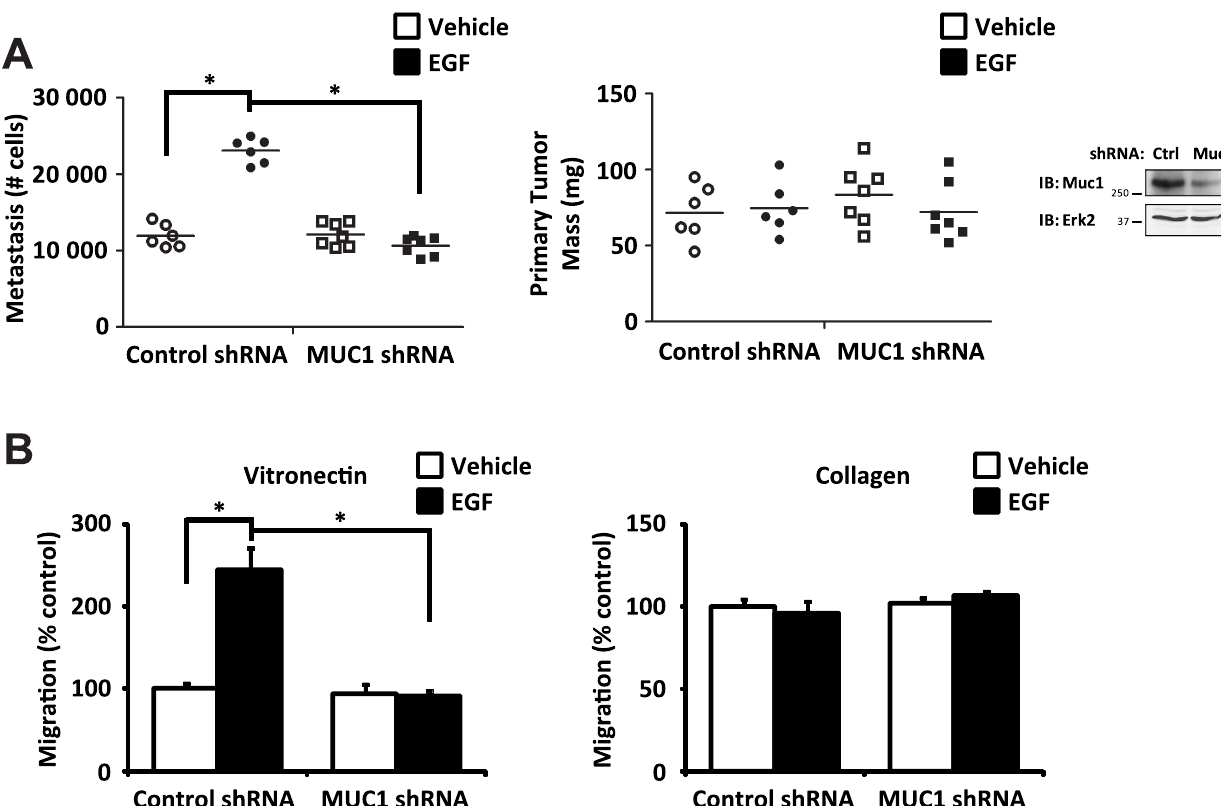
Figure 1. MUC1 is required for EGF-dependent tumor cell metastasis. ( a ) FG human pancreatic carcinoma cells expressing a control shRNA or MUC1 shRNA and stimulated with or without a 15 minute treatment of EGF were inoculated on to the chorioallantoic membrane of 10 day-old embryonated chicken eggs and assessed for spontaneous pulmonary metastasis (left) and primary tumor formation (right) after 10 days. Cells were washed with PBS prior to inoculation to remove EGF. Metastasis quantified by Q-PCR for human Alu sequence and chicken GAPDH was normalized to a standard curve. Each point represents a separate egg, n $ 6 eggs per group. Immunoblot detecting MUC1 expression (far right). P , 0.0001 comparing metastasis for cells expressing control shRNA with or without EGF treatment; P =0.08 comparing metastasis for cells expressing MUC1 shRNA with or without EGF treatment; P , 0.0001 comparing metastasis for cells expressing control shRNA or MUC1 shRNA with EGF treatment; P =0.6 comparing primary tumor mass across groups. ( b ) Migration assays on a vitronectin (left) or a collagen (right) substrate comparing FG cells expressing a control shRNA or MUC1 shRNA with or without a 15 minute pre-treatment of EGF. Cells were washed with PBS prior to inoculation on Boyden chambers to remove EGF. P =0.002 comparing migration on vitronectin for cells expressing control shRNA with or without EGF treatment; P =0.8 comparing migration on vitronectin for cells expressing MUC1 shRNA with or without EGF treatment; P =0.002 comparing migration on vitronectin for cells expressing control shRNA or MUC1 shRNA with EGF treatment; P =0.5 comparing migration on collagen across groups. Results are expressed as mean 6 s.e.m. of three replicates. Similar findings were observed in 3 independent experiments.